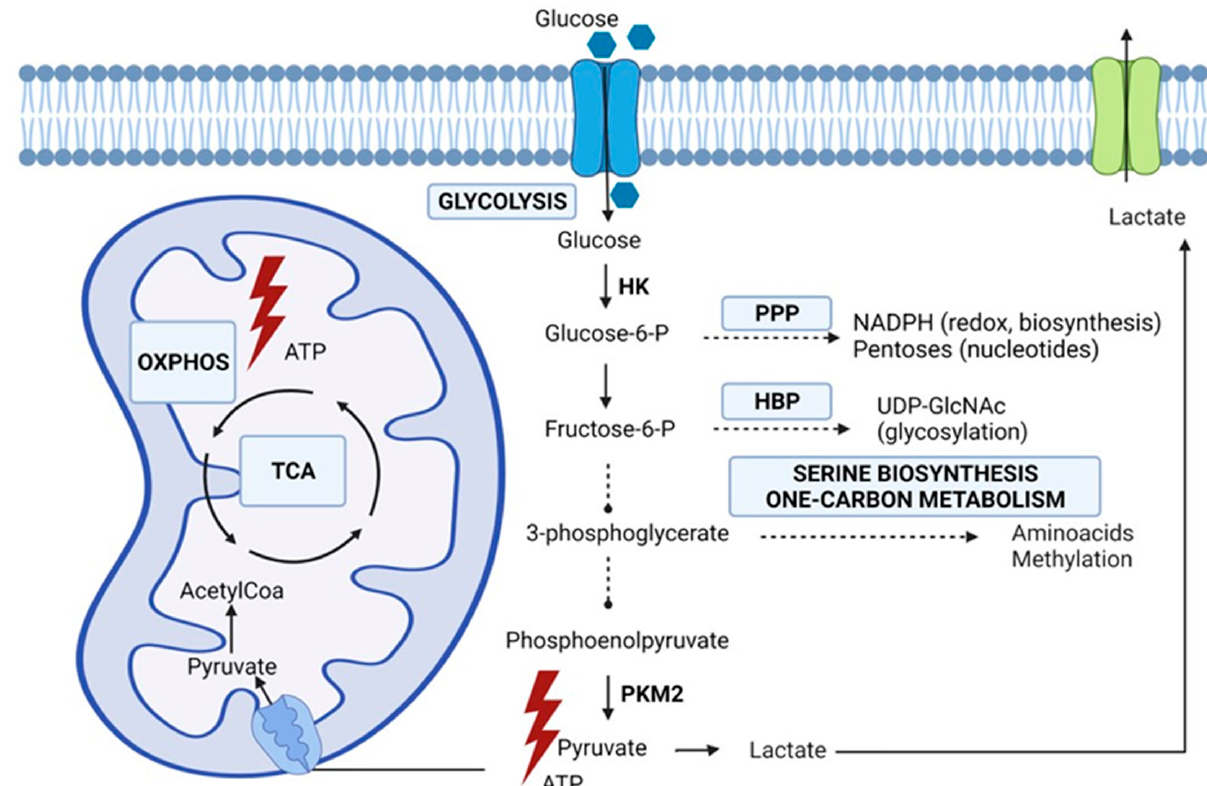
Figure 1. Glucose metabolic pathways emanating from glycolysis involved in lung cancer cell metabolism. HBP (hexosamine biosynthesis), HK (hexokinase), OXPHOS (oxidative phosphorylation), PKM2 (pyruvate kinase isoform M2), PPP (pentose phosphate pathway), TCA (tricarboxylic acid) cycle. Original figure drawn with Biorender.